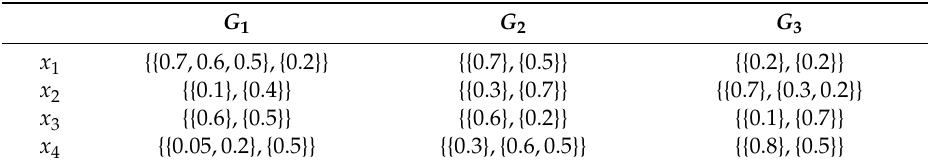
Table 11. The decision matrix based on q -RDHFEs.